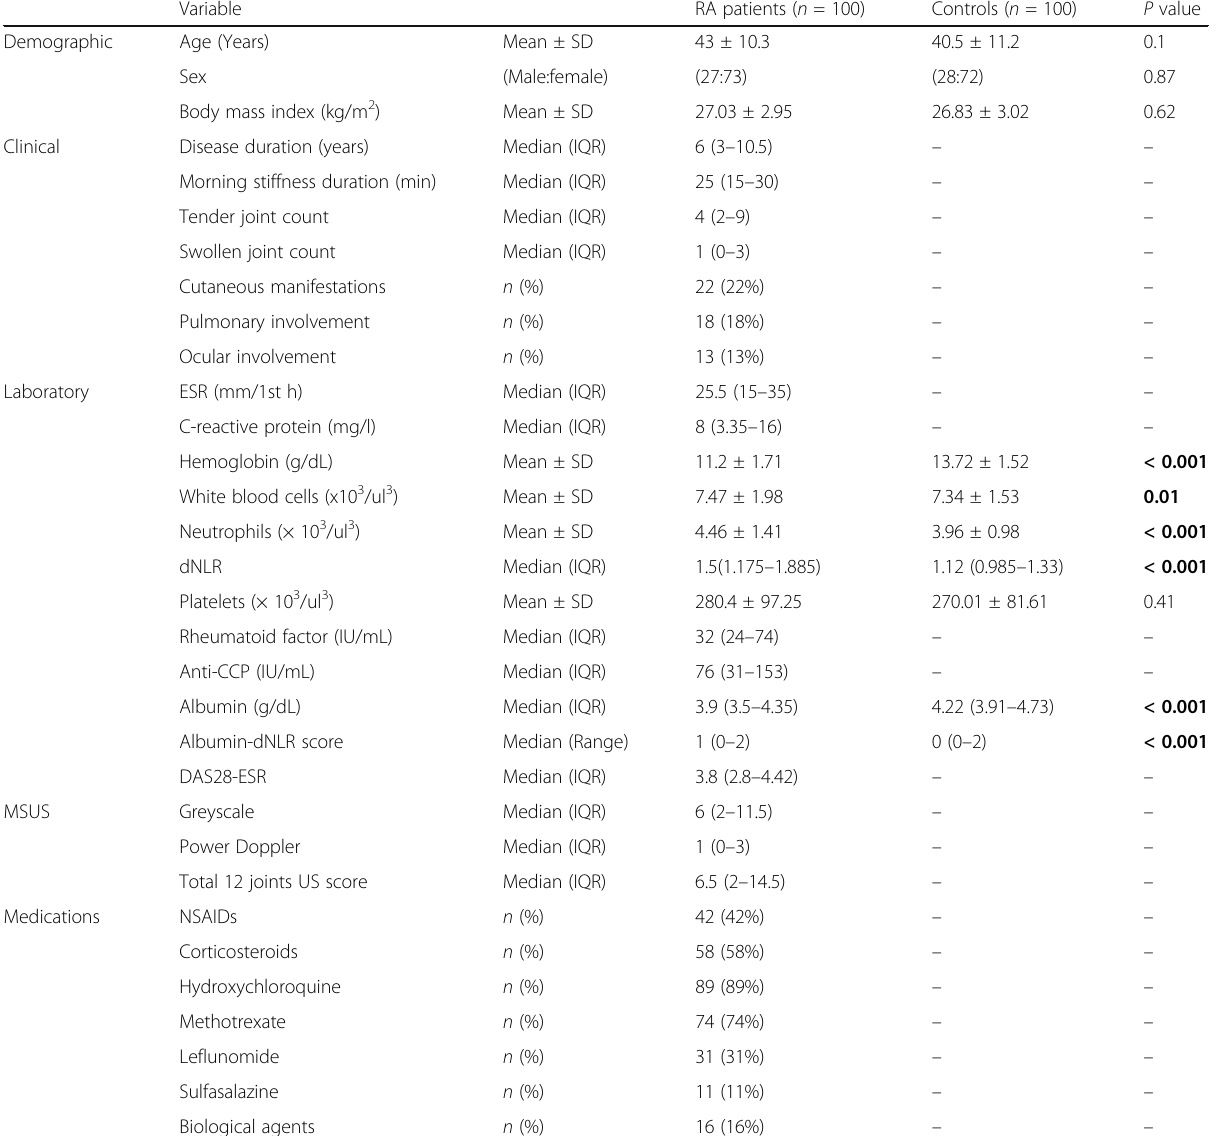
Table 1 Baseline characteristics of rheumatoid arthritis (RA) patients and the controls